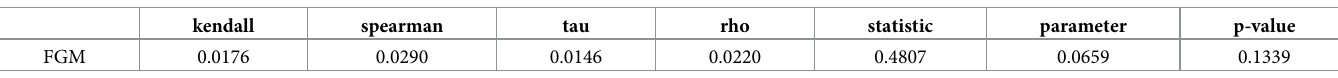
Fig 9. Estimated cdf, pdf and pp-plot for stress variable for serum creatinine data. https://doi.org/10.1371/journal.pone.0282581.g009 Table 5. Goodness of fit measures for FGM copula.